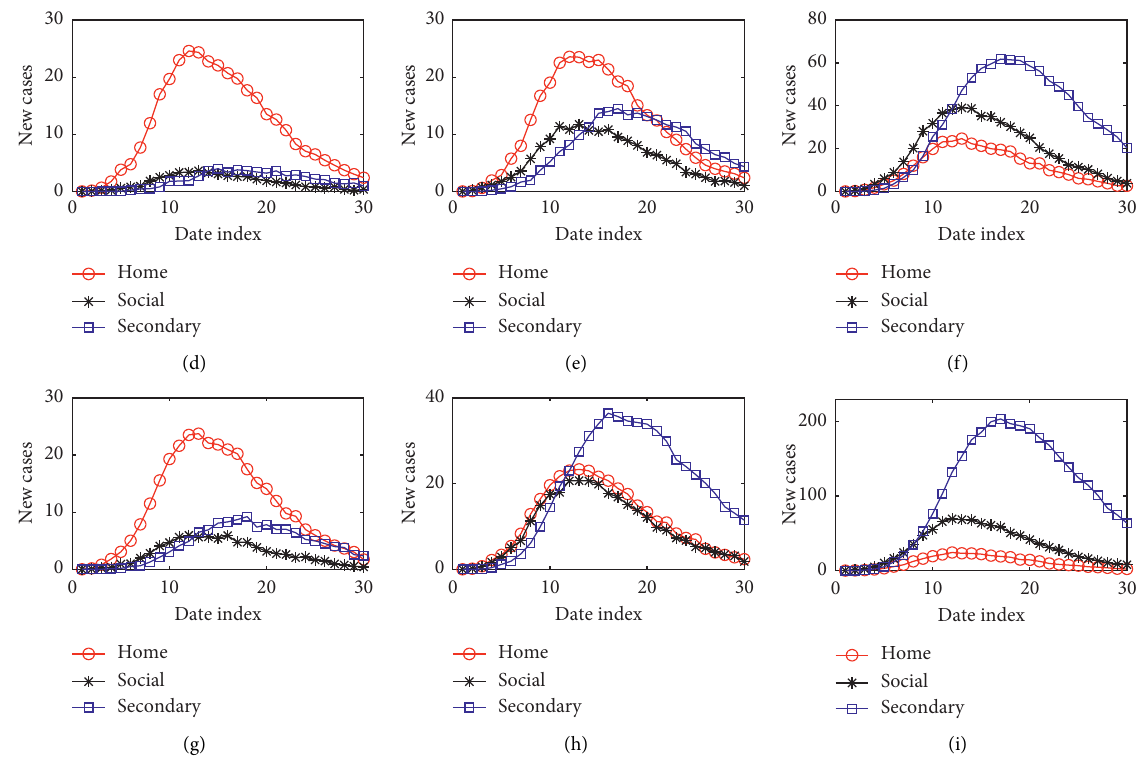
Figure 7: The simulation results of the age-dependent branching process with immigration. The red, blue, and black curves are for the local infectees divided as Home, Social, and Secondary. Home and Social refer to the infected cases of the imported cases taking place at home and out of home, respectively. Secondary refers to the infectees caused by Home and Social. The nine subfigures are drawn with different combinations of the values for the testing parameters as α � 0 . 1 , 0 . 4 , and 0 . 7 and λ � 0 . 4 , 1 . 4 , and 4 . 8. (a) α � 0.1 and λ � 0.4. (b) α � 0.1 and λ � 1.4. (c) α � 0.1 and λ � 4.8. (d) α � 0.4 and λ � 0.4. (e) α � 0.4 and λ � 1.4. (f) α � 0.4 and λ � 4.8. (g) α � 0.7 and λ � 0.4. (h) α � 0.7 and λ � 1.4. (i) α � 0.7 and λ �